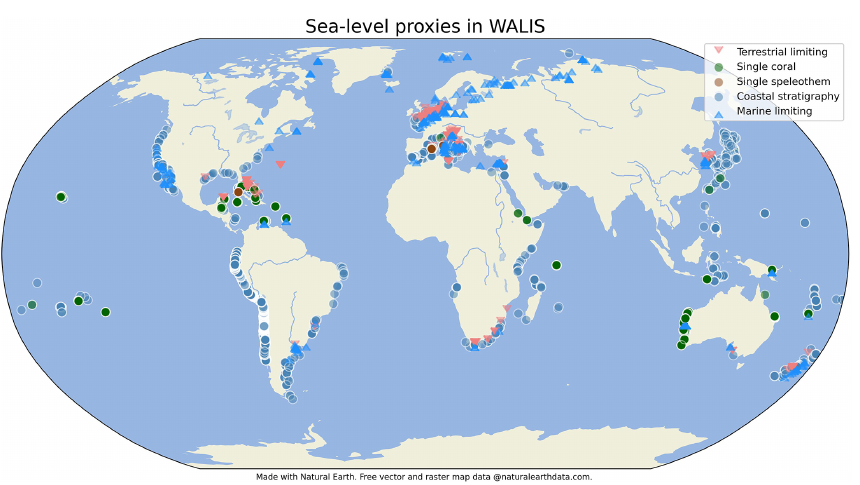
Figure 6. Location of sea-level proxies included in WALIS 1.0, divided by category. The code used to create this image is available from Rovere et al. (2022). Map made with Natural Earth, background from https://www.naturalearthdata.com (last access: 15 December